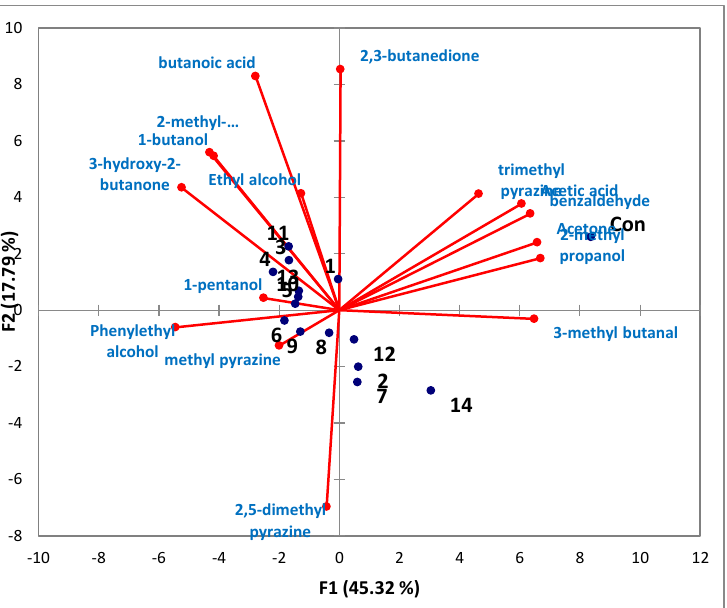
Figure 3. Principal component analysis of volatiles identified from each strain culture. 1. B. sonorensis , 2. B. subtilis -H1, 3. B. subtilis -H2, 4. B. subtilis -H3, 5. B. subtilis -H4, 6. B. subtilis -H5, 7. B. subtilis -H6, 8. B. amyloliquefacience -J1, 9. B. amyloliquefacience -J2, 10. Bacillus . sp-K1, 11. Bacillus . sp-K2, 12. Bacillus . sp-K3, 13. Bacillus . sp-K4, 14. B. Frigoritolerance.